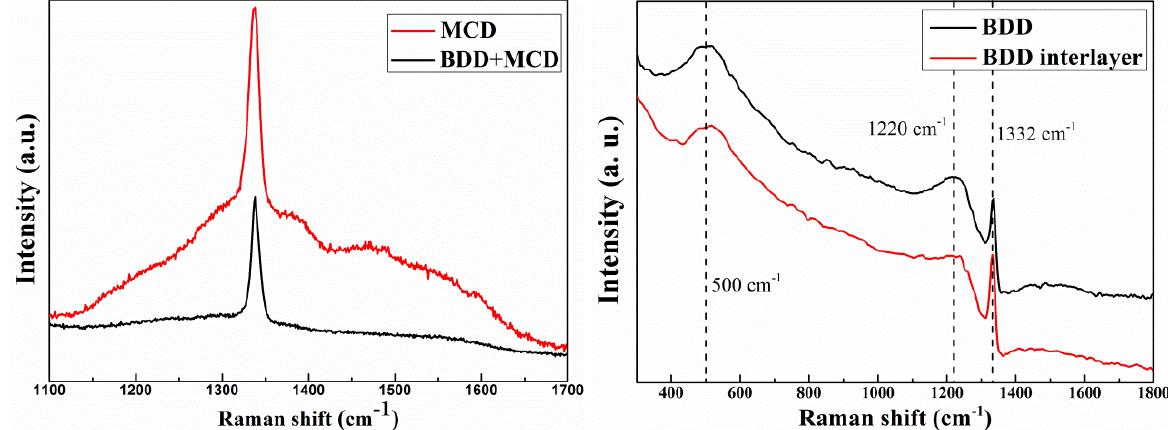
Figure 3. Raman spectra of as-deposited diamond films on micro